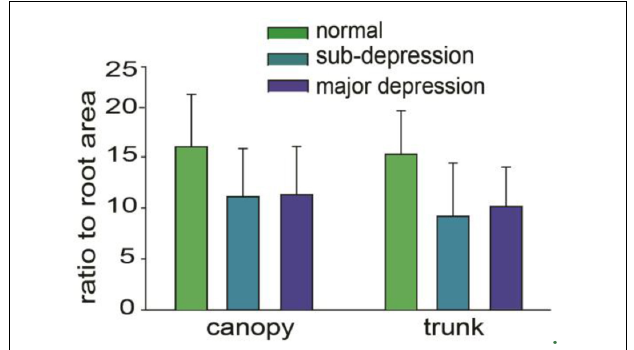
FIGURE 4 | Comparisons among the ratios of canopy area, trunk area to root area.